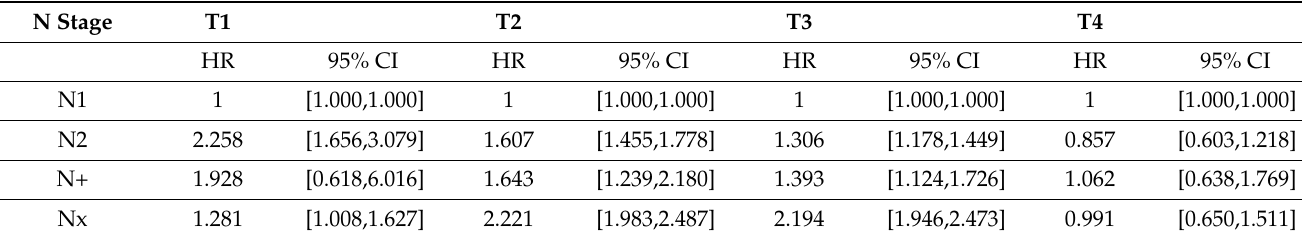
Table 4. Factors associated with risk of death in GBC patients stratified by AJCC 8th T-stage classification.